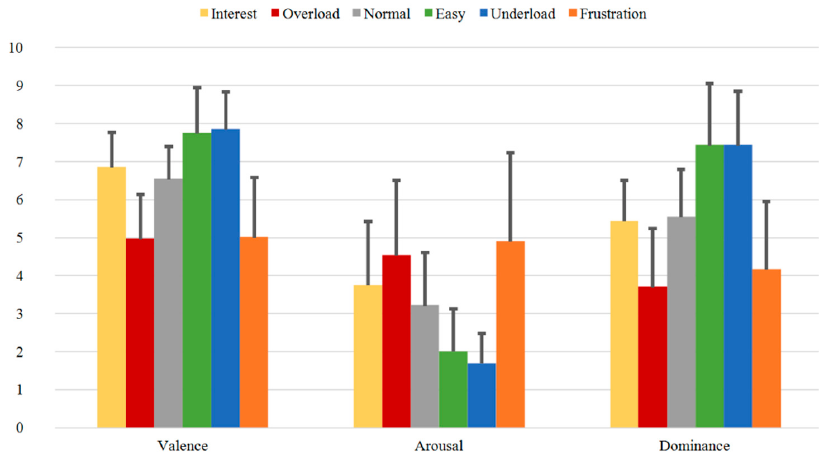
Figure 9. SAM Ratings of Group B1 for all sequences with mean Valence, Arousal, and Dominance.